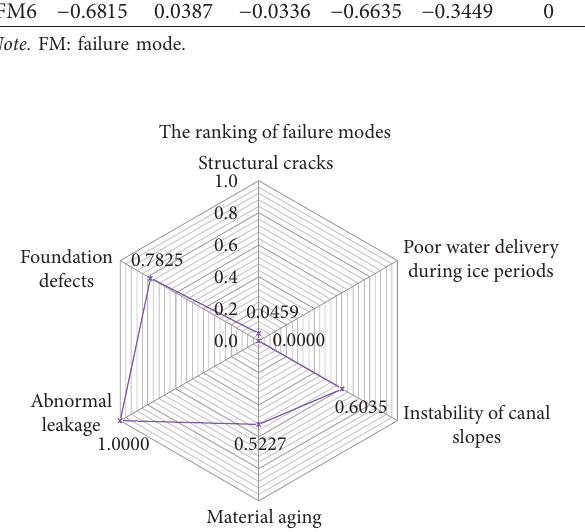
Figure 4: The ranking of six failure modes.